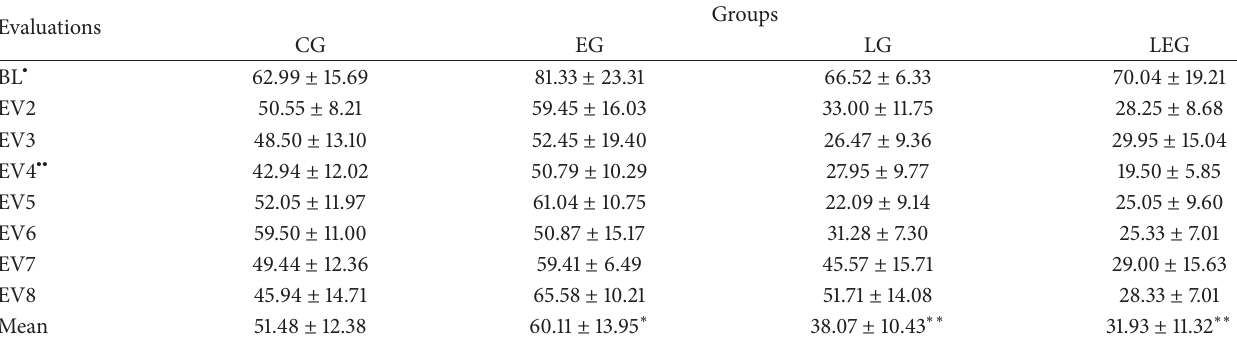
Table 1: Data of mechanical allodynia measurements in different groups of study (mean ± standard deviation in grams) according to evaluation (baseline: BL; evaluation: